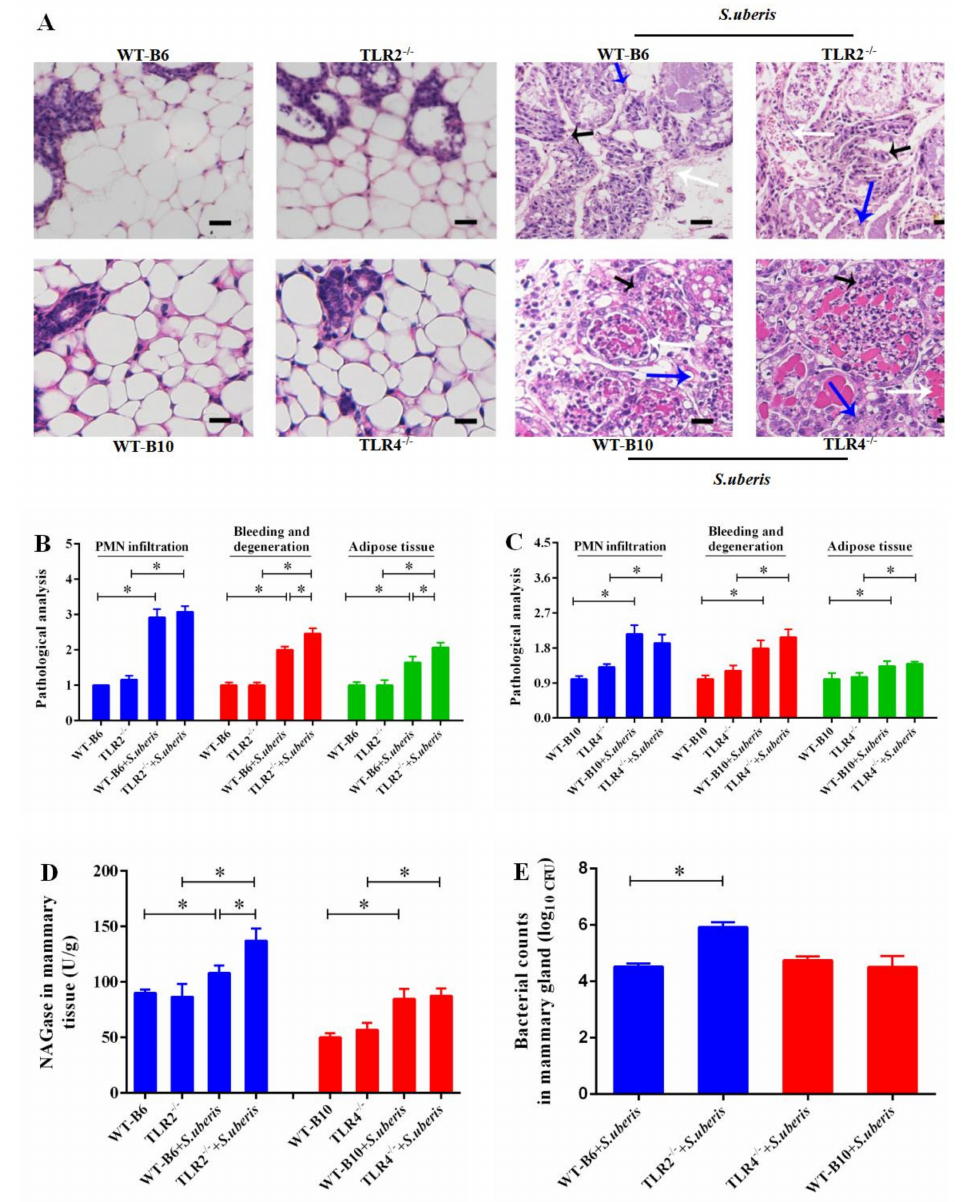
Figure 1. TLR2 mediates tissue damage and anti- S. uberis infection in mammary gland. ( A ) Mammary gland staining by hematoxylin and eosin of WTB6 (isotype-matched negative control of TLR2 − / − ), WTB10 (isotype-matched negative control of TLR4 − / − ), TLR2 − / − , TLR4 − / − mice with or without S. uberis . Polymorphonuclear neutrophilic leukocyte (PMN) infiltration (black arrow), the bleeding and degeneration (white arrow), adipose tissue (blue arrow). Images are representative of n = 6 animals per genotype. Scale bars, 50 µ m. ( B , C ) The bleeding and degeneration, PMN infiltration, and adipose tissue were observed by light microscopic and scored by double blind method. B stands the scores for TLR2 − / − group and C is for TLR4 − / − group ( D ) NAGase activity was analyzed in mammary gland. ( E ) Viable bacteria were counted via the plate with Todd–Hewitt broth (THB) agar medium. Experiments D and E were repeated three times. All data were presented as the means ± SEM ( n = 6). * ( p < 0.05) = significantly di ff erent between the indicated